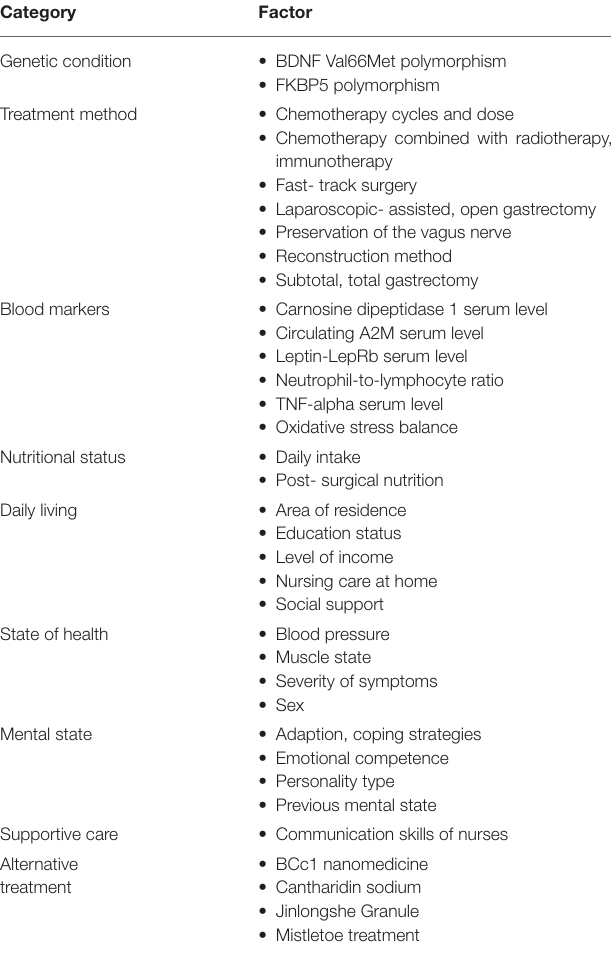
TABLE 4 | Factors potentially influencing psycho-social burden (in order of